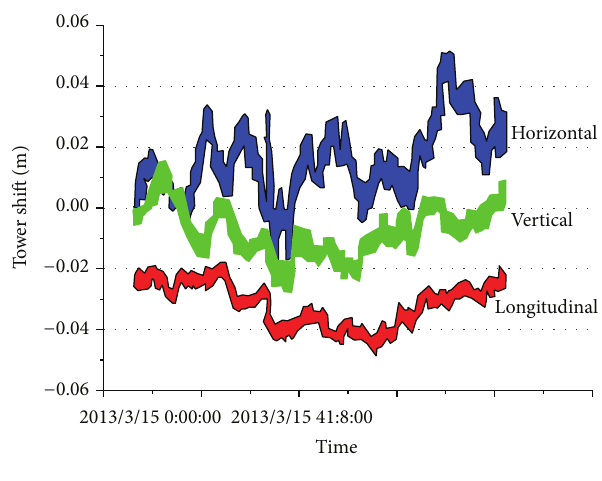
Figure 18: Tower shift.